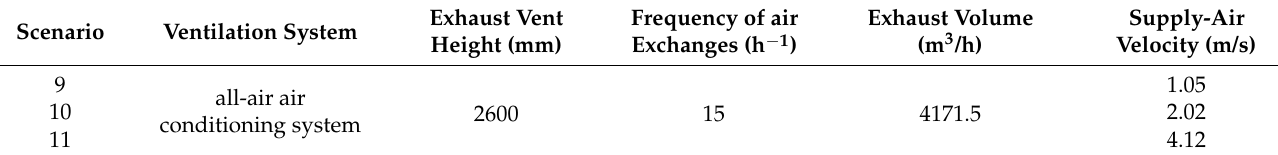
Table 10. Boundary conditions of supply-air velocity.